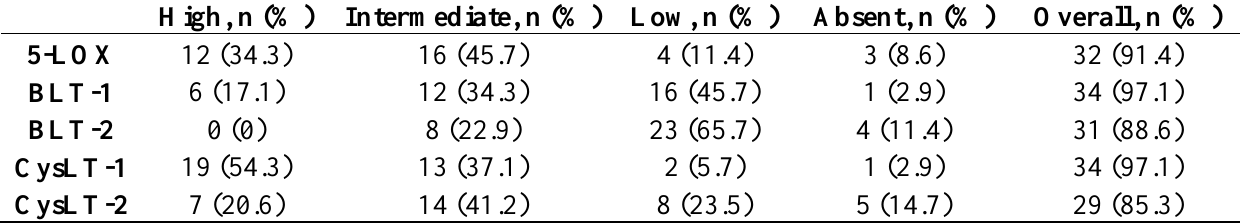
Table 1. IHC expression of 5-LOX, BLT-1, BLT-2, CysLT-1 and CysLT-2 in GC.